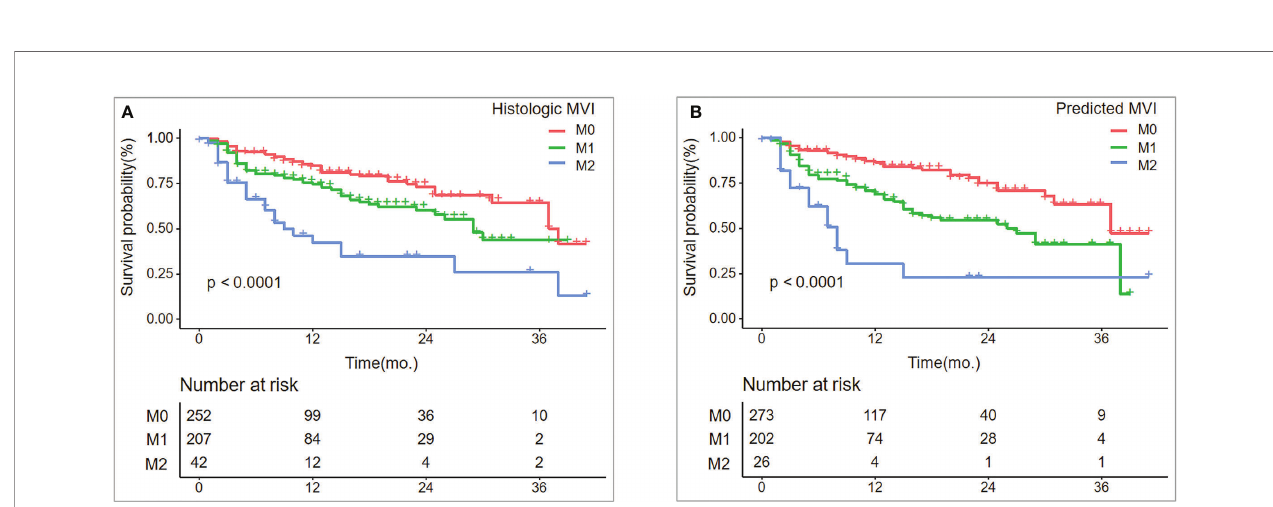
FIGURE 5 | Recurrence-free survival (RFS) between histologic MVI and predicted MVI.RFS (A, B) curves were scaled by histologic MVI status and fi nal model- predicted MVI risk grades with Kaplan Meier analysis.